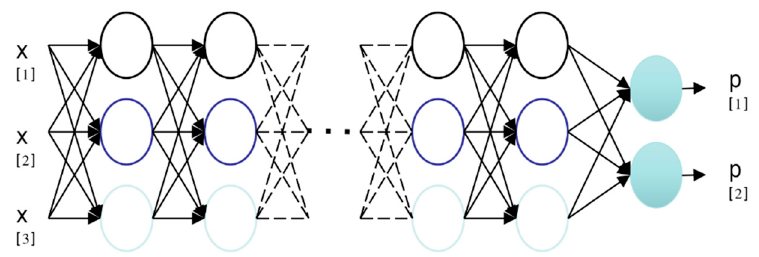
Figure 2. SC operation diagram.